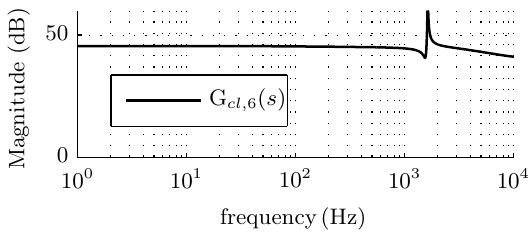
Figure 4. Magnitude response of G cl ,6 ( s ) .